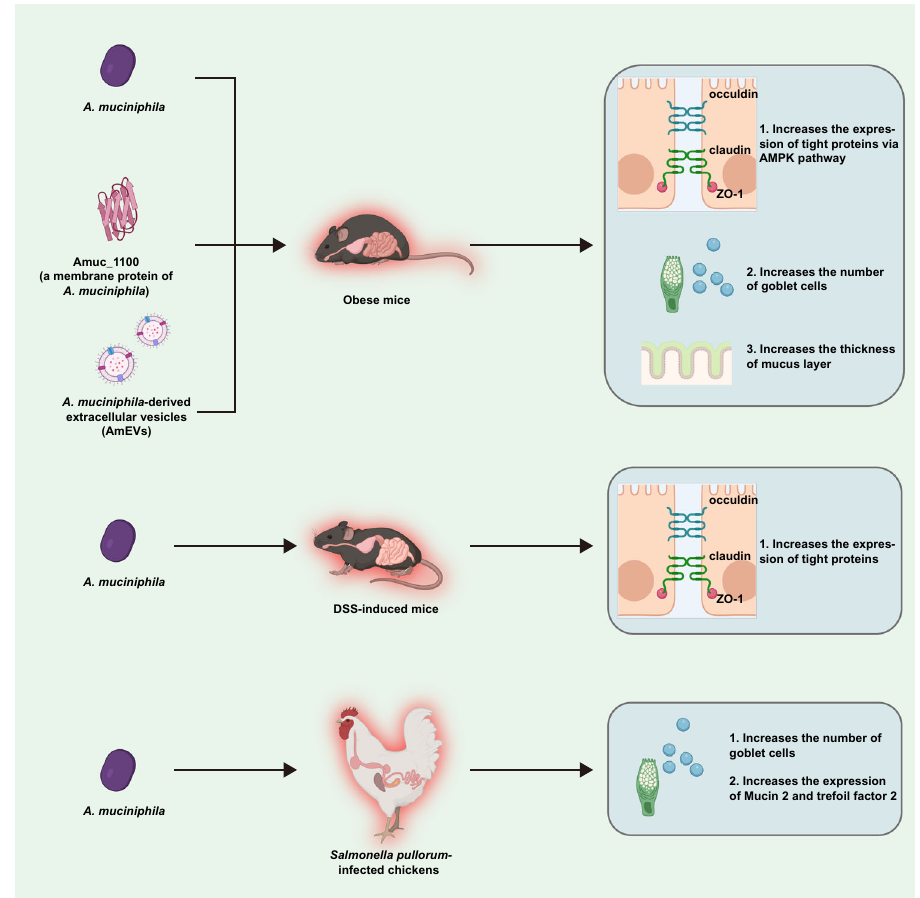
Fig. 2 The possible mechanisms of A. muciniphila regulating intestinal barrier summarized according to existing references. All fi gures are created with